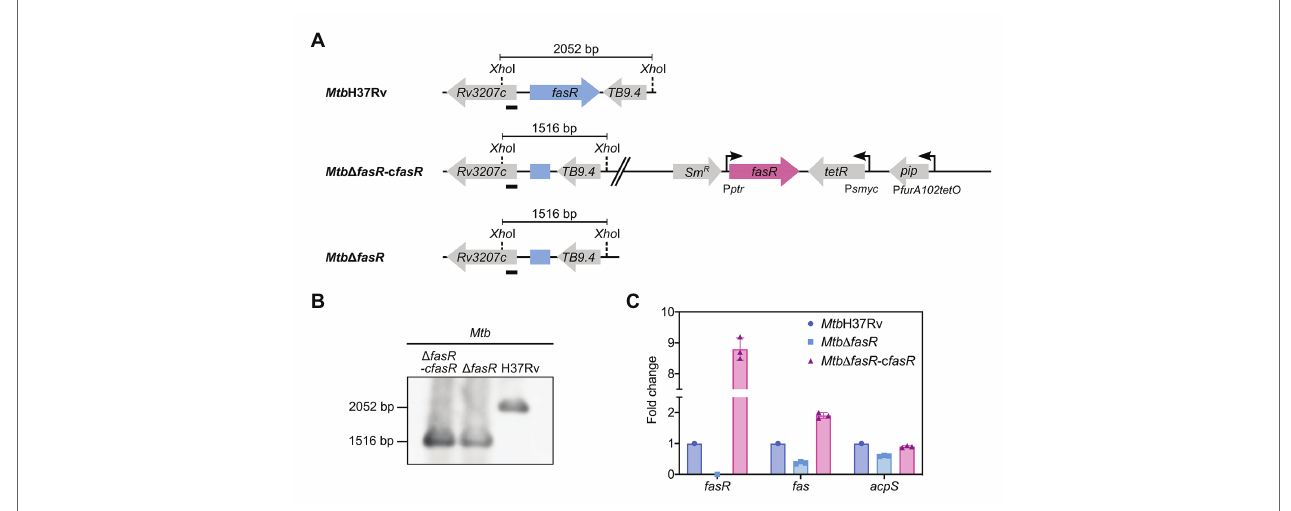
FIGURE 1 | Construction and characterization of M. tuberculosis fasR mutant. (A) Schematic representation of the genetic organization of the chromosomal region of fasR in the wild-type H37Rv strain ( Mtb H37Rv), fasR conditional knockdown strain ( Mtb ∆ fasR -c fasR ), and fasR KO strain ( Mtb ∆ fasR ). (B) Southern blot analysis of the different strains: chromosomal DNA was digested with Xho I and probed for hybridization with the probe indicated with a black bar, corresponding to the 5 ' end of the Rv3207 gene. (C) Relative expression levels of fasR , fas , and acpS mRNAs measured by quantitative RT-PCR. Values were normalized to sigA and to the wild-type strain ( Mtb H37Rv). Samples for RNA extraction were collected at OD 600nm ~0.3. qPCR reactions were performed in technical duplicates, and three independent biological replicates were used for quantitative